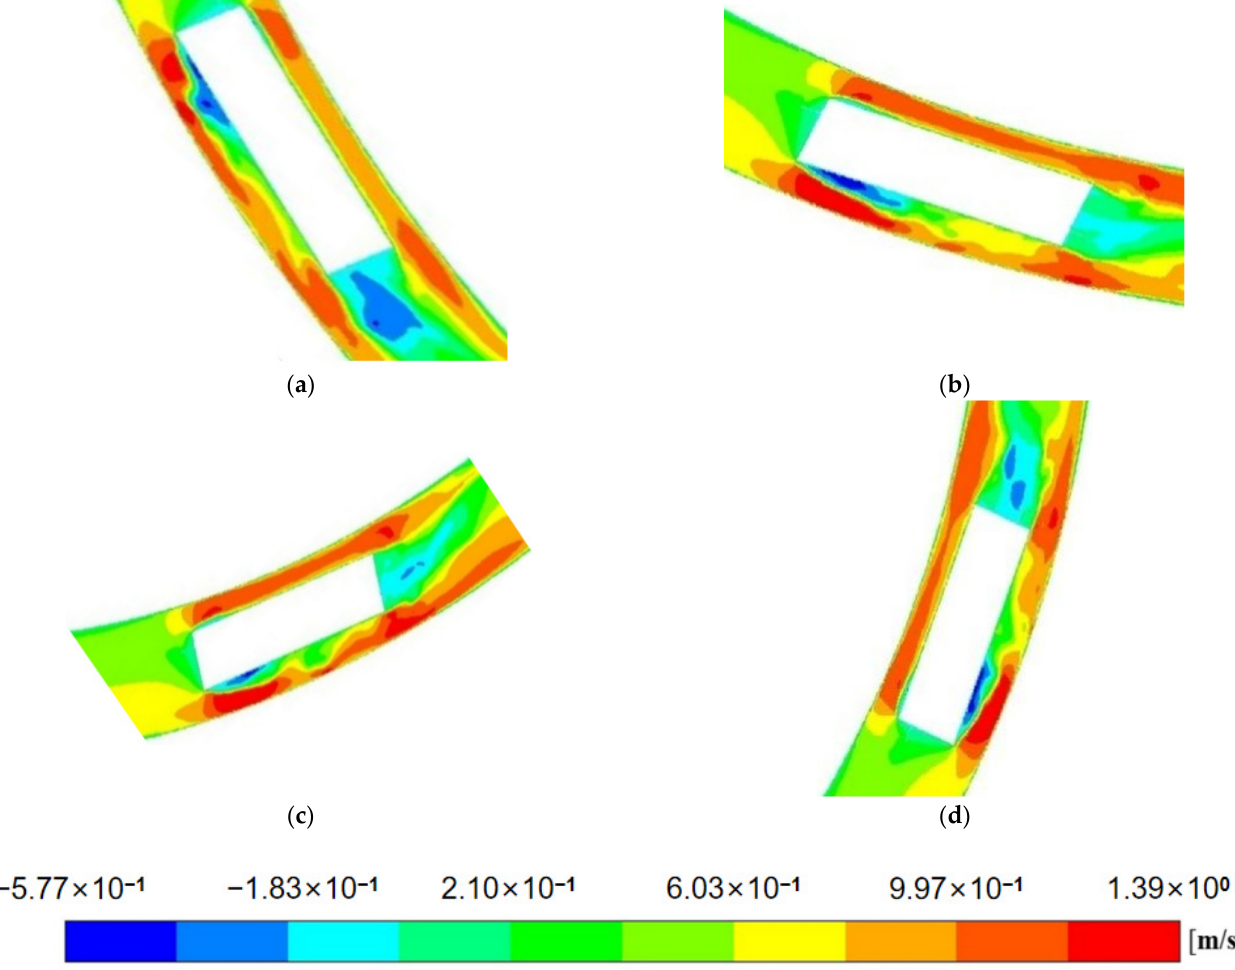
Figure 5. Cloud chart of the time-averaged distribution of overall capsule velocity. ( a ) Position 1; ( b ) position 2; ( c ) position 3; ( d ) position 4.